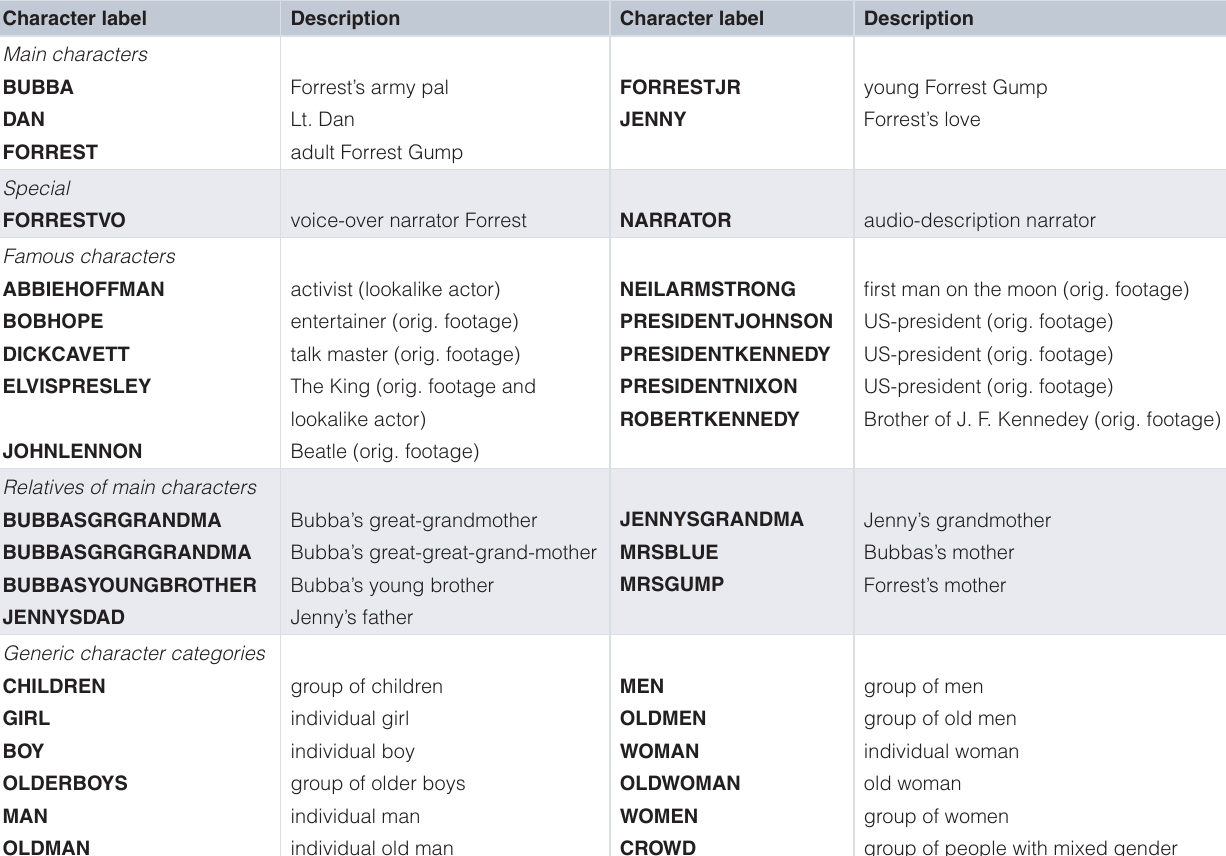
Table 2. Consolidated character labels. Any annotation of a portrayed emotion is associated with exactly one of these 36 labels. While main characters, their relatives, and famous characters have individual labels, all remaining characters in the movie are aggregated into generic categories that preserve information on gender, age group, and